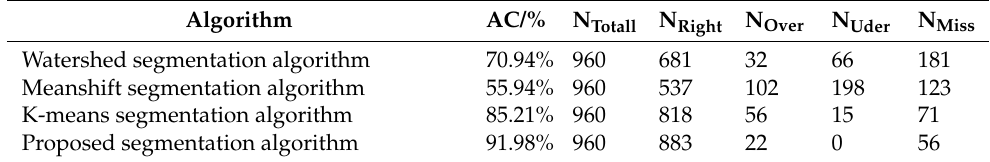
Table 1. Comparison of the different segmentation